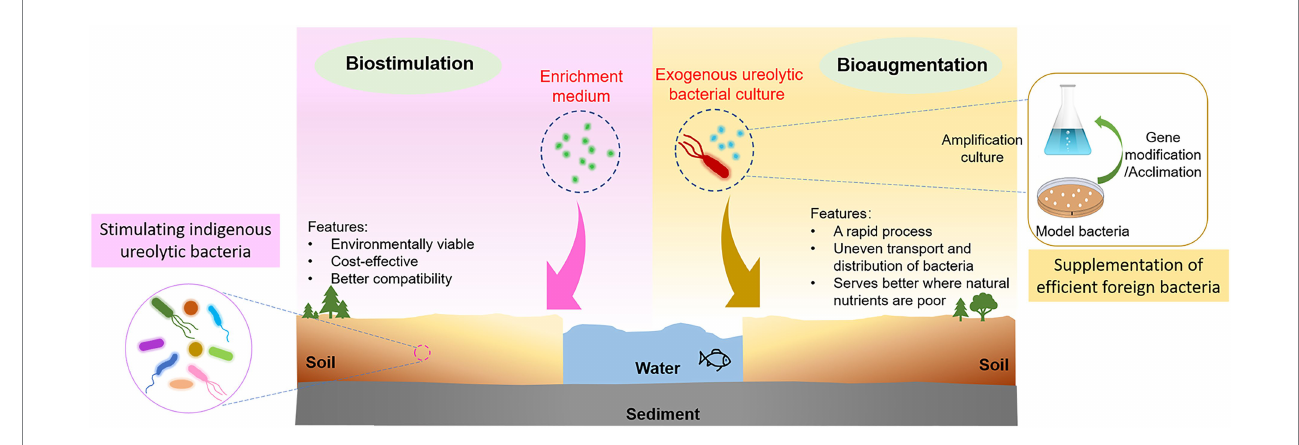
FIGURE 2 Pathways of MICP: bioaugmentation and biostimulation.